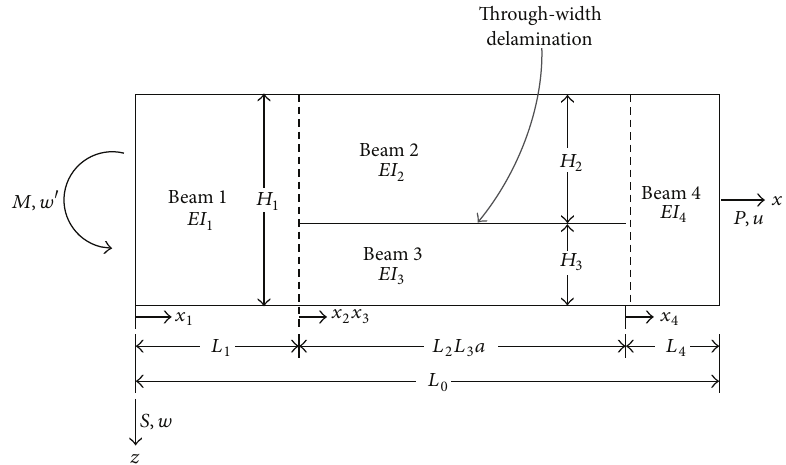
Figure 1: The coordinate system and notation for a delaminated layered